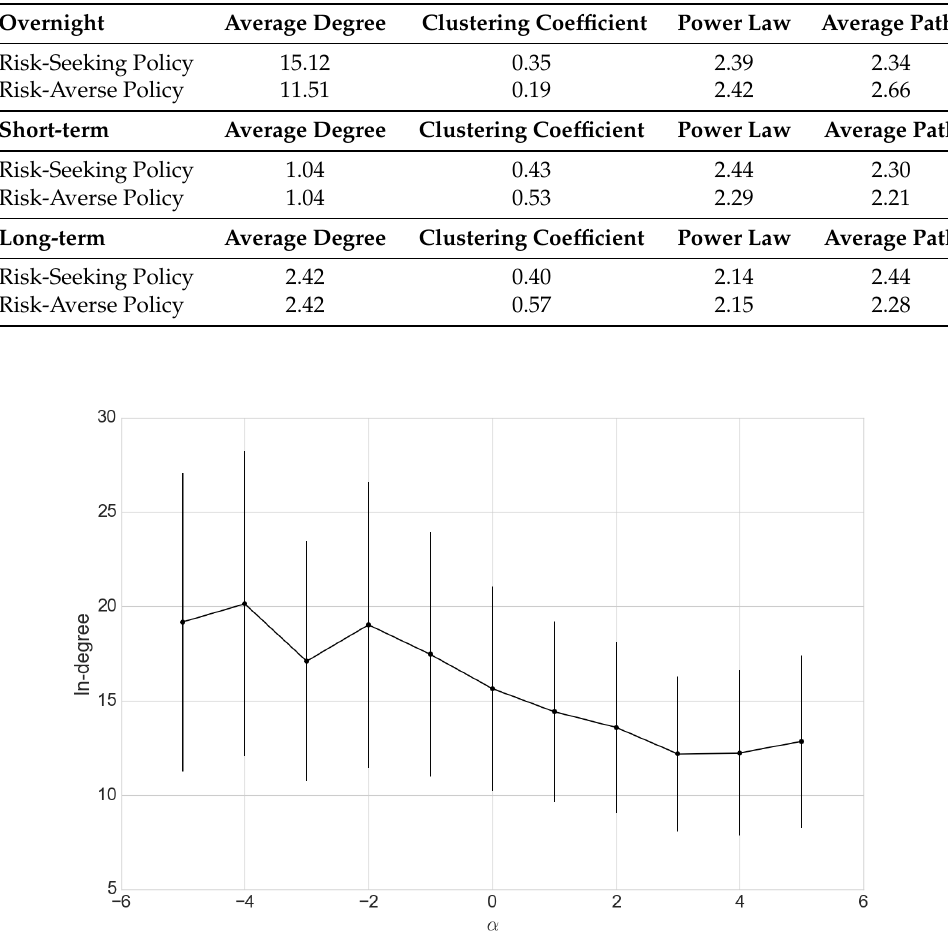
Figure 8. Risk preference α vs. average